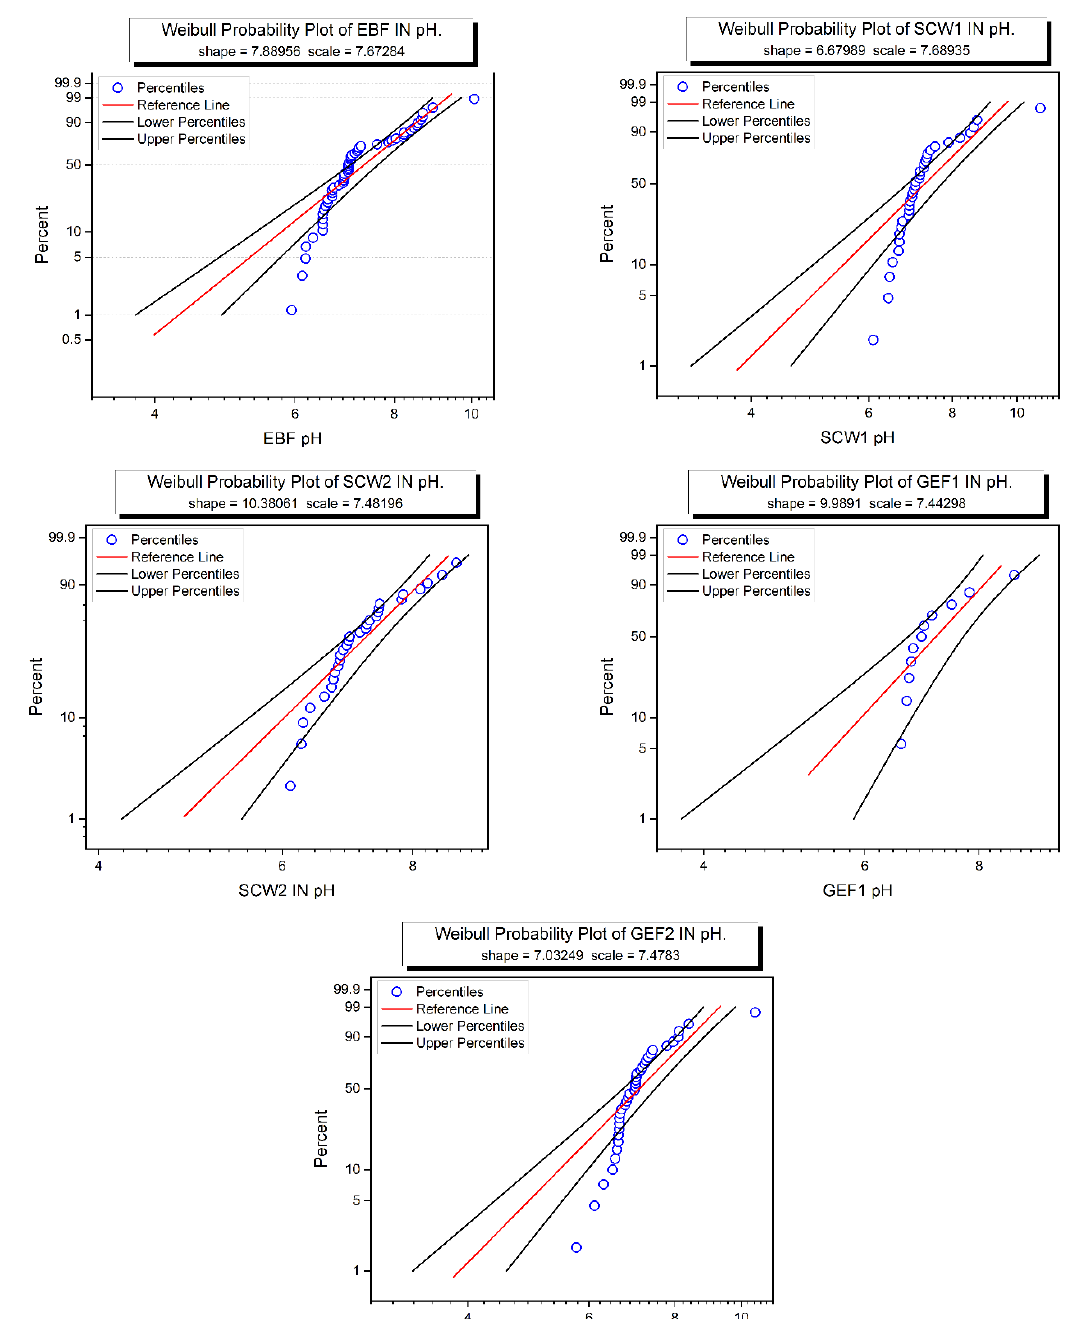
Figure 3. Weibull probability plot for pH parameter Figure 3 . Weibull probability plot for pH parameter (IN).